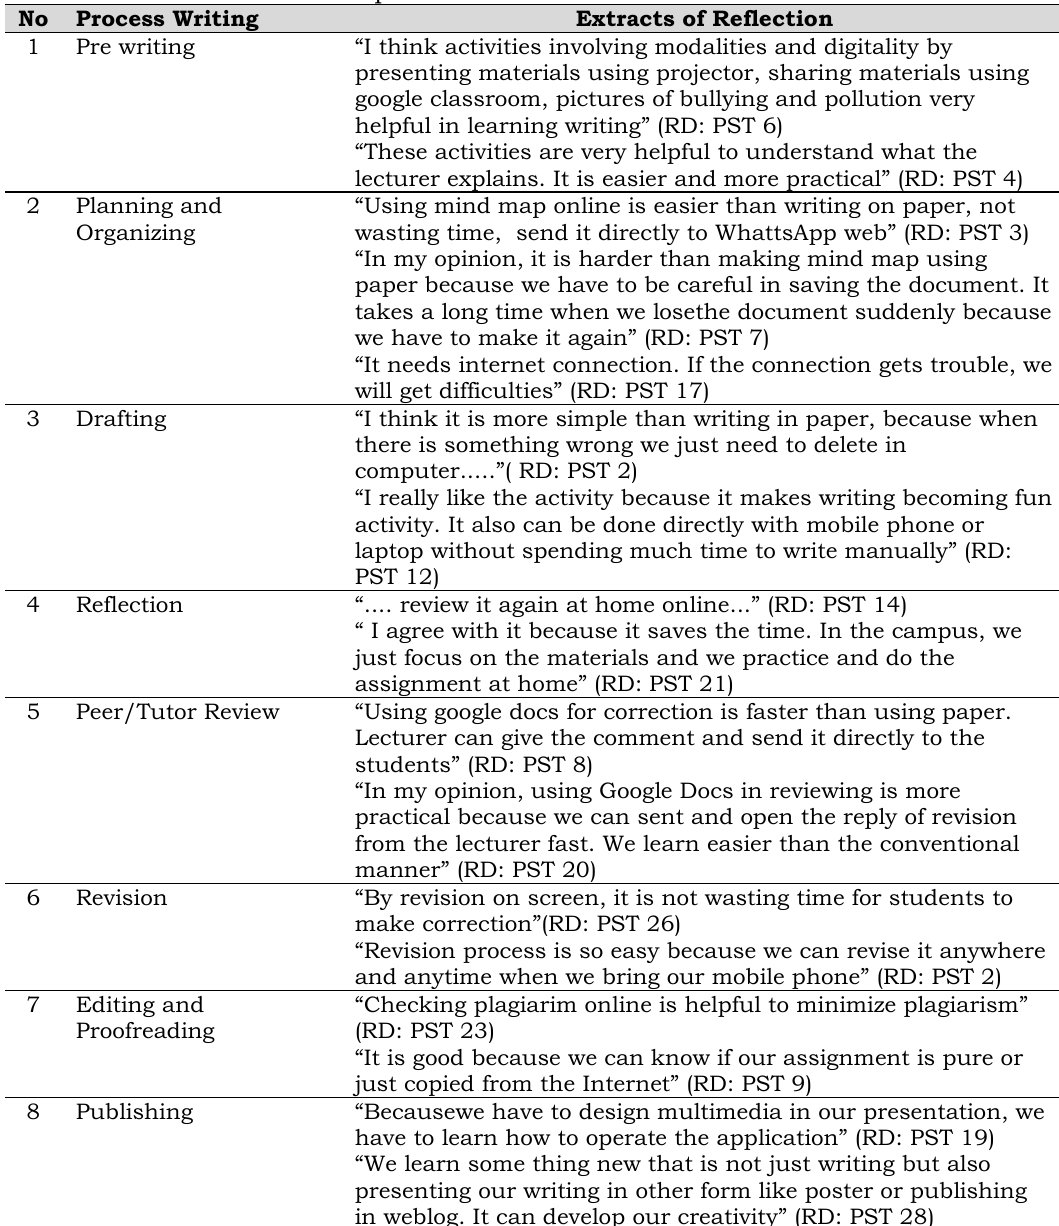
Table 3. Sample reflection of the activities from